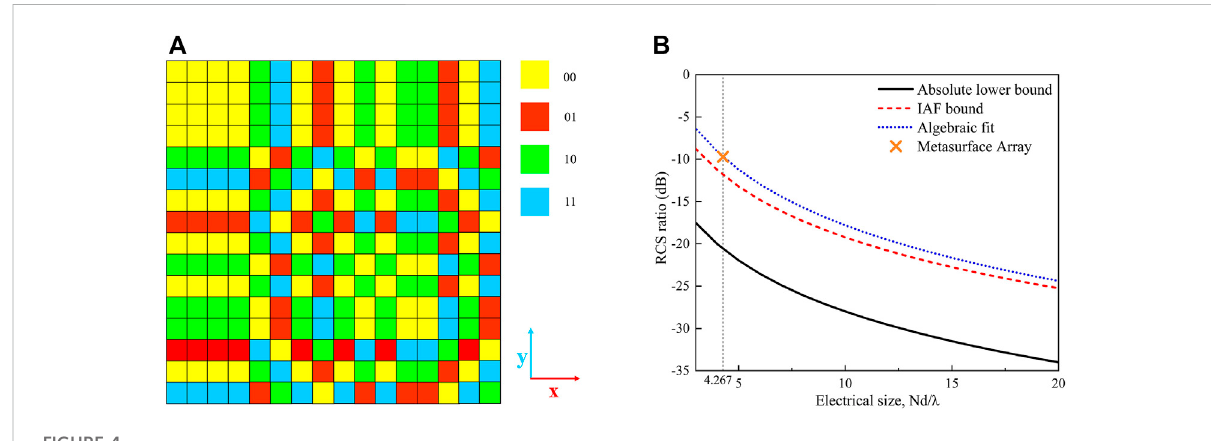
FIGURE 4 (A) Colored coding matrix of the array. (B) RCS-ratio scaling laws in Moccia et al. (2017).